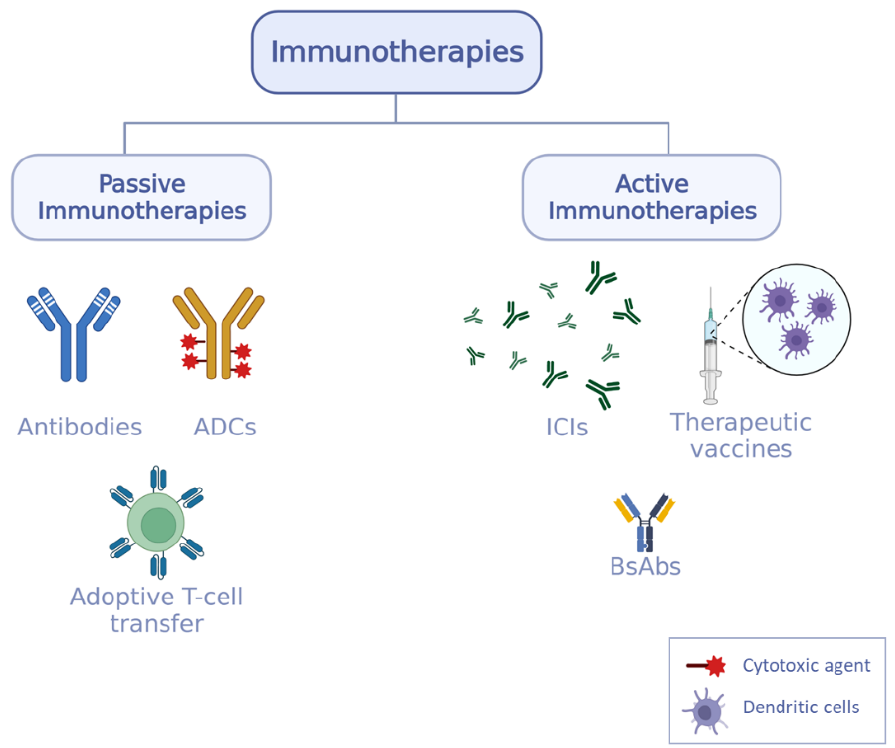
Figure 2. Anticancer immunotherapies classified into passive and active immunotherapies. Passive immunotherapies are the administration of immune molecules directly and active immunotherapies stimulate the patient immune response. ADCs = antibody drug conjugates, T-cell = T lymphocyte, ICIs = immune checkpoint inhibitors, BsAbs = bispecific antibodies.